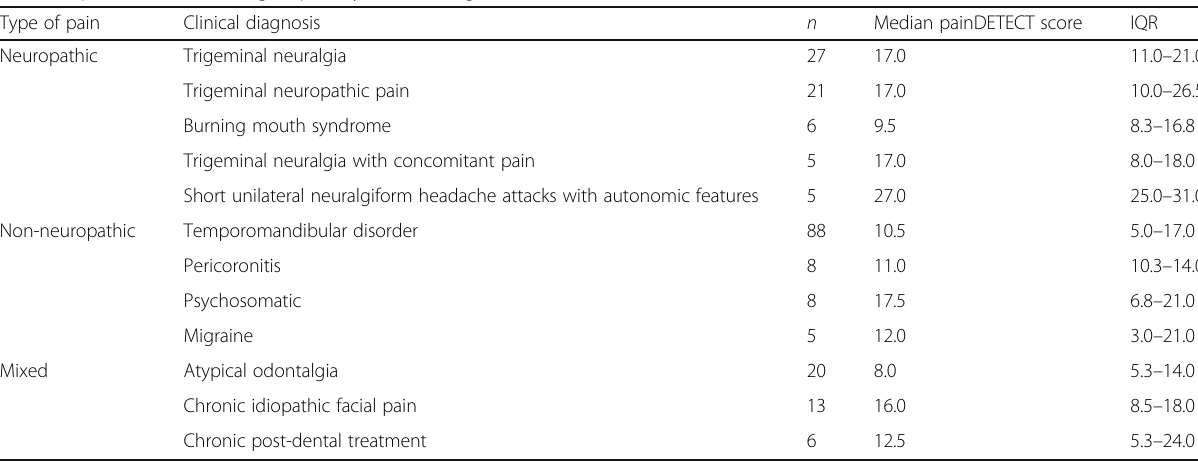
Table 3 painDETECT scores grouped by clinical diagnosis Type of